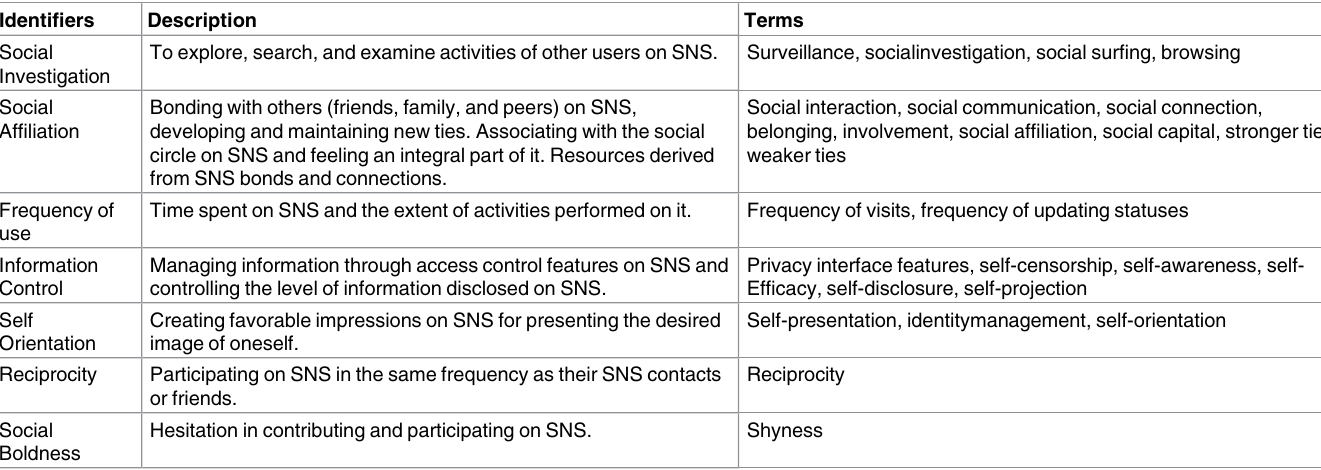
Table 11. Classification of